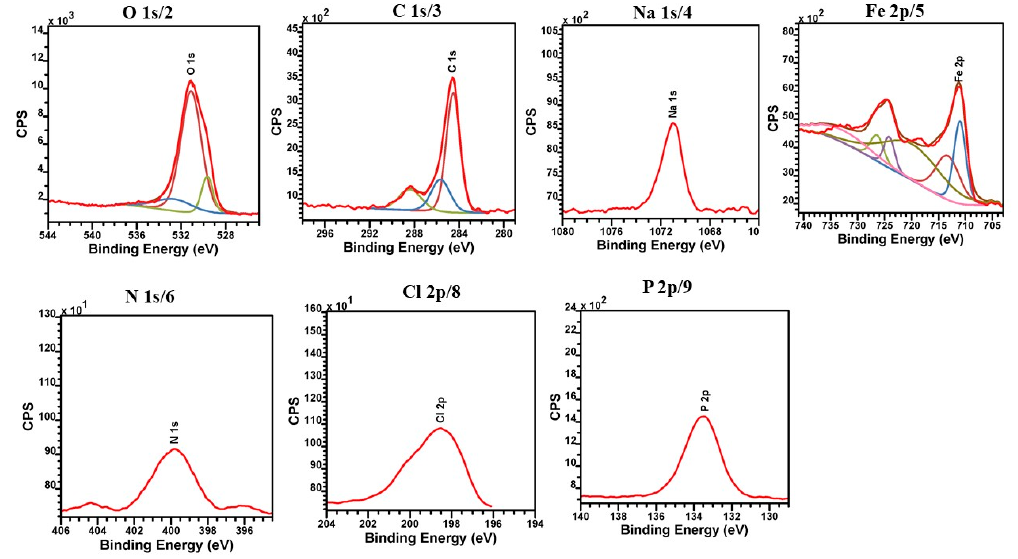
Figure 6. High resolution O 1s, C 1s, Na 1s, Fe 2p, N 1s, Cl 2p, and P 2p XPS peaks obtained from the surface of S235 low-carbon steel substrate using ATP-6-AHA as an inhibitor after five days of treatment in 3.5% NaCl solution (colors indicate typical bonds, details in the text).